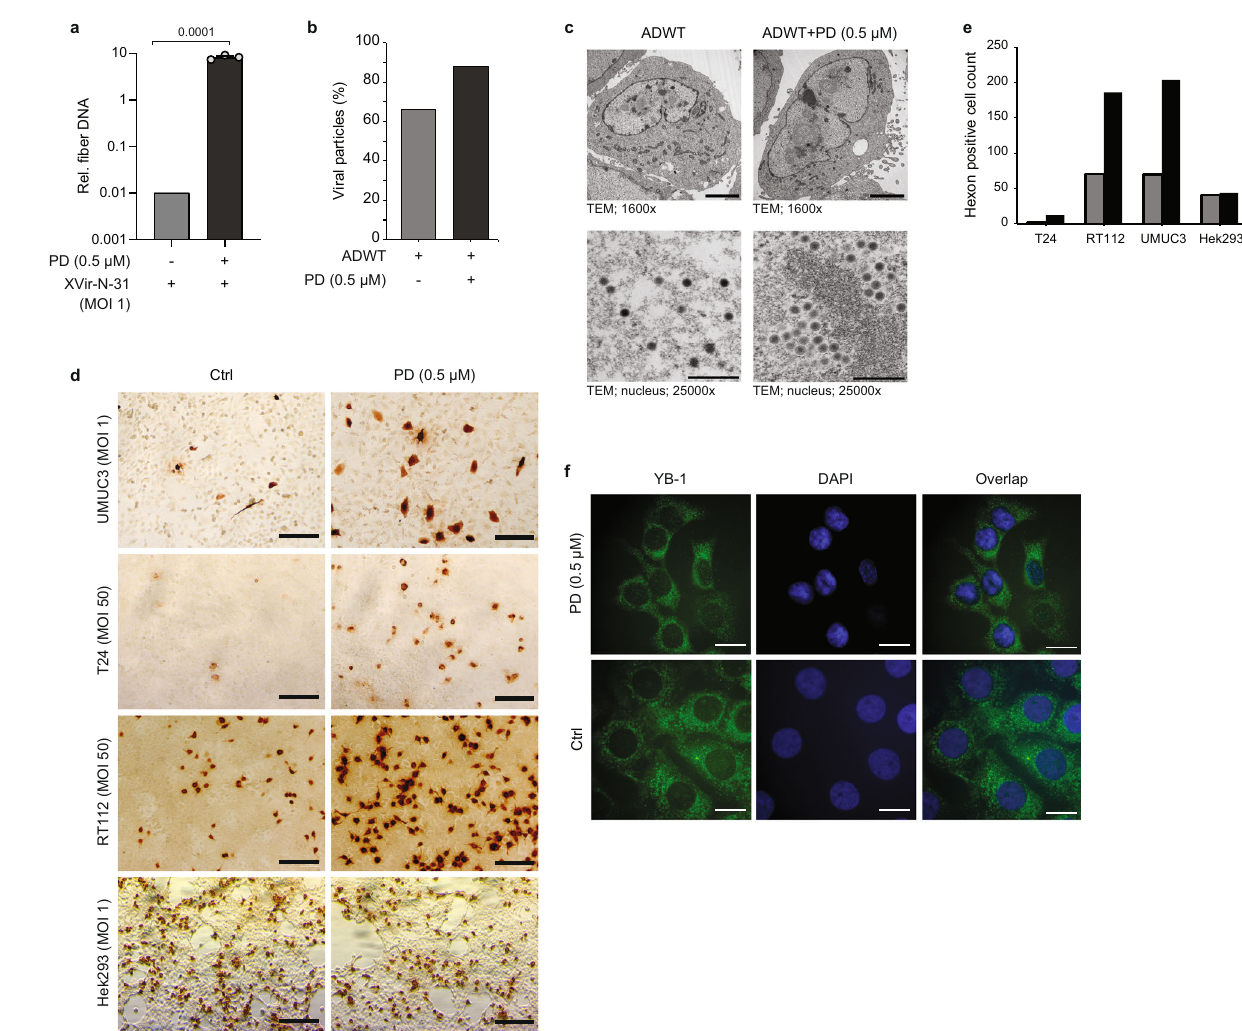
Fig. 3 | CDK4/6i induces a cellular environment that augments virus replica- tion.a Viralgenomereplicationwasassessed byqPCRtoamplifyviral fi berDNAin T24 cells pre-treated for 24h with Palbociclib and infected with XVir-N-31 (MOI 1). Data are represented as relative fi ber DNA at indicated time points compared to fi ber DNA at 4hpi as the baseline ( n =3, mean±SD). b Quanti fi cation of viral par- ticlesinelectronmicroscopyintwoindependentsamples.Datarepresentthemean of two experiments. c Representative electron microscopy images showing viral proliferation at 48hpi in T24 cells pre-treated with Palbociclib and infected with ADWT (MOI 50). Scale bars inupper and lower panels represent 4 µ m and 400nm,